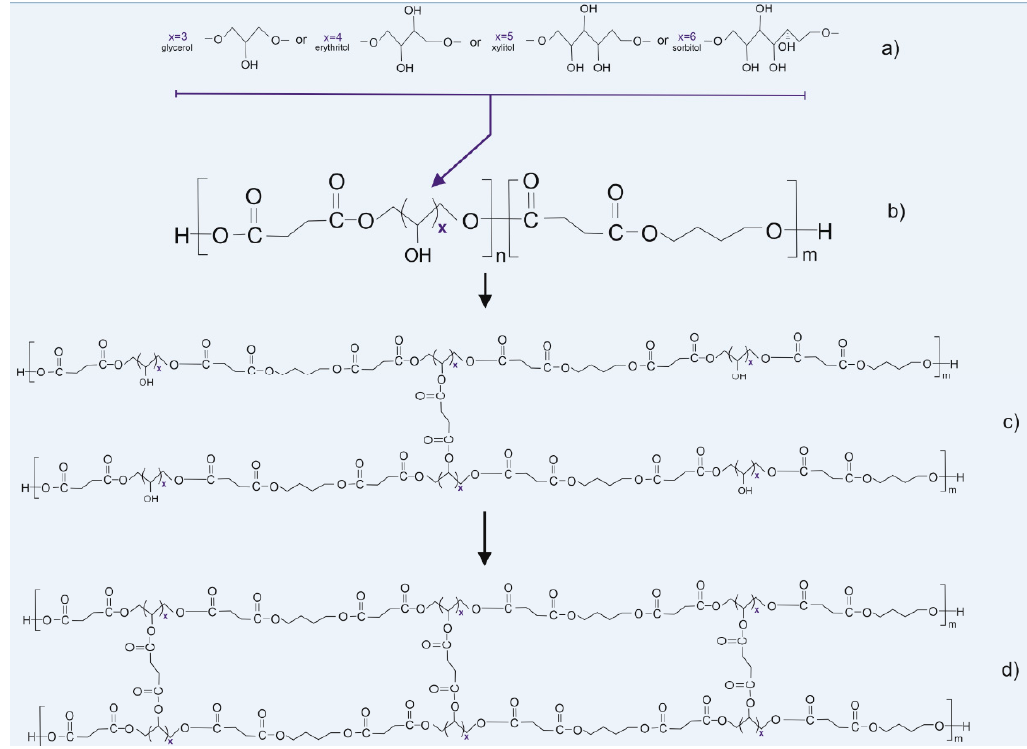
Figure 1. Scheme of synthesis and modification of the polymers: ( a ) sugar alcohols used in the synthesis, ( b ) prepolymer structure, ( c ) thermally cross-linked polymer, and ( d ) radiation cross-linked polymer.